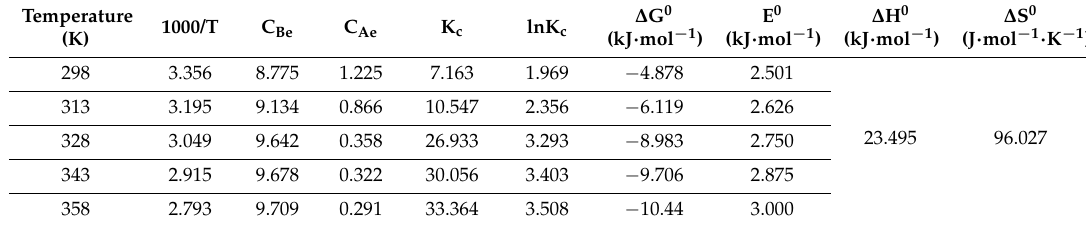
Table 1. Thermodynamic parameters for phenol sorption on to magnetic ZnO nanotubes. Temperature (K)